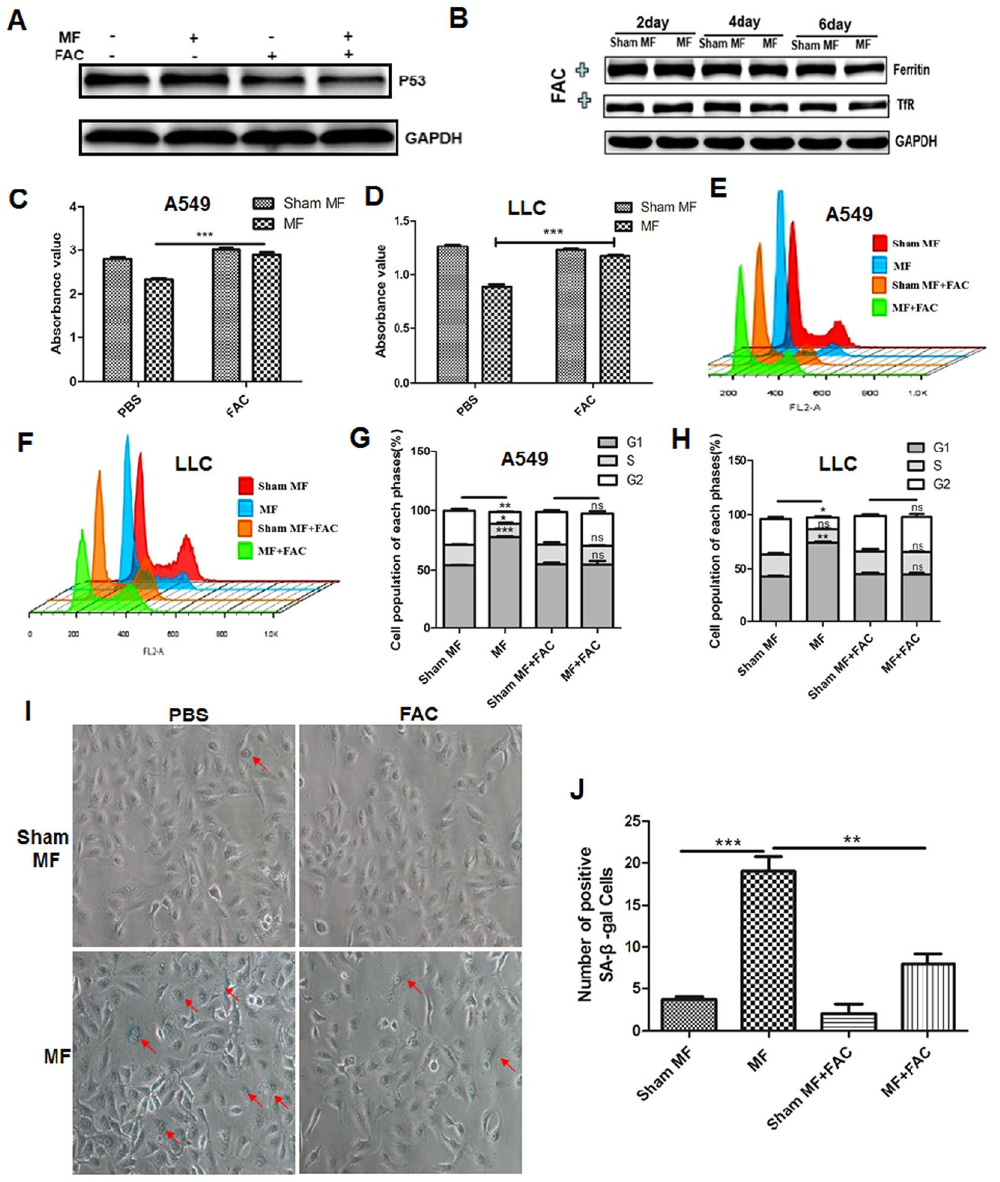
Figure 7. Low frequency MF stabilized p53 protein via inducing cell iron metabolism dysfunction. A549 and LLC cells were pre-incubated with medium containing FAC (100 uM) for 24 h and were exposure to MF or Sham MF for 6 days. ( A ) Protein level of P53 in LLC cells was detected using western blot. Numbers under each blot are relative intensity of the blot. ( B ) Protein expression of TfR and ferritin in LLC cells were detected using western blot. Numbers under each blot are relative intensity of the blot. ( C , D ) Cell proliferation of A549 cells and LLC cells was detected using CCK-8 assay. ( E , F ) Cell cycle of A549 and LLC cells were detected using flow cytometery. ( G , H ) Mean cell proportion in each phase was shown. ( I , J ) Representative image of SA- β - Gal staining assay was showed and numbers of SA- β -Gal positive cells was calculated. All experiments were repeated three times. Data represent Mean ± SEM. * P < 0.05, ** P < 0.01, *** P <